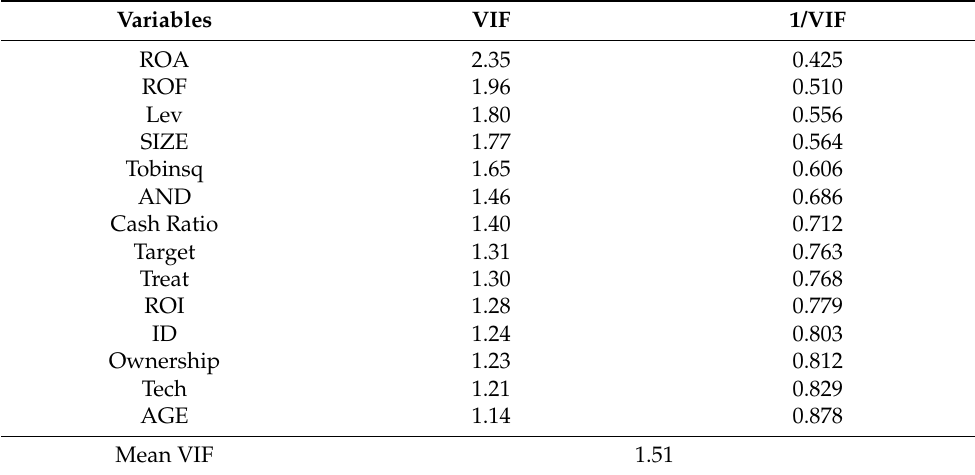
Table 6. Variance inflation factor